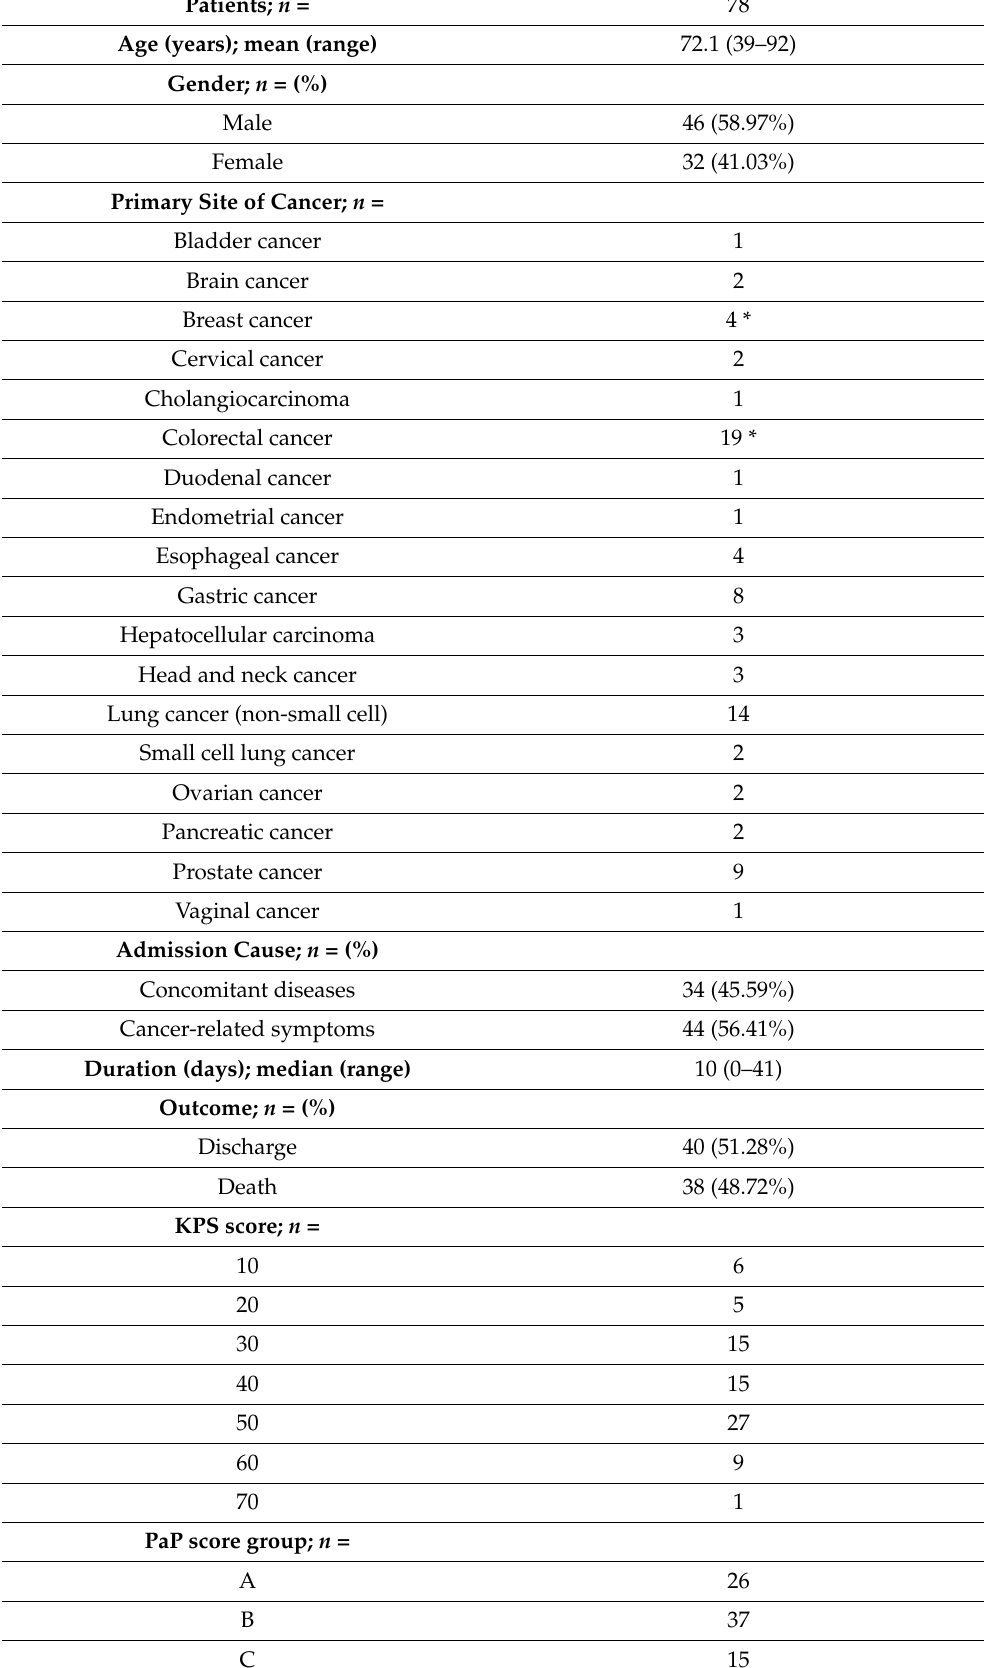
Table 1. Characteristics of recruited patients ( p < 0.05 is considered as significant